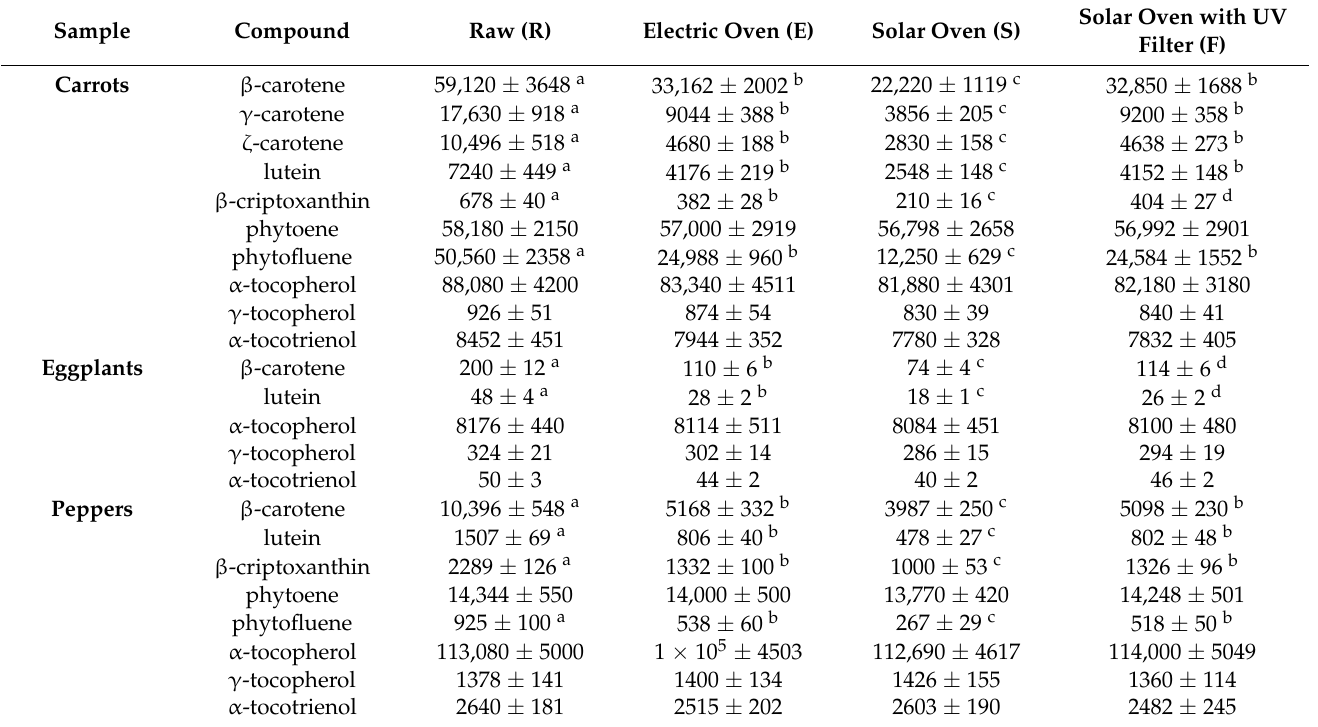
Table 1. Mean chromatographic areas ( × 10 3 ) with associated standard deviations of the fat-soluble micronutrients detected in raw and cooked foods (average values calculated on 3 replicated analyses and normalized with respect to the weight of